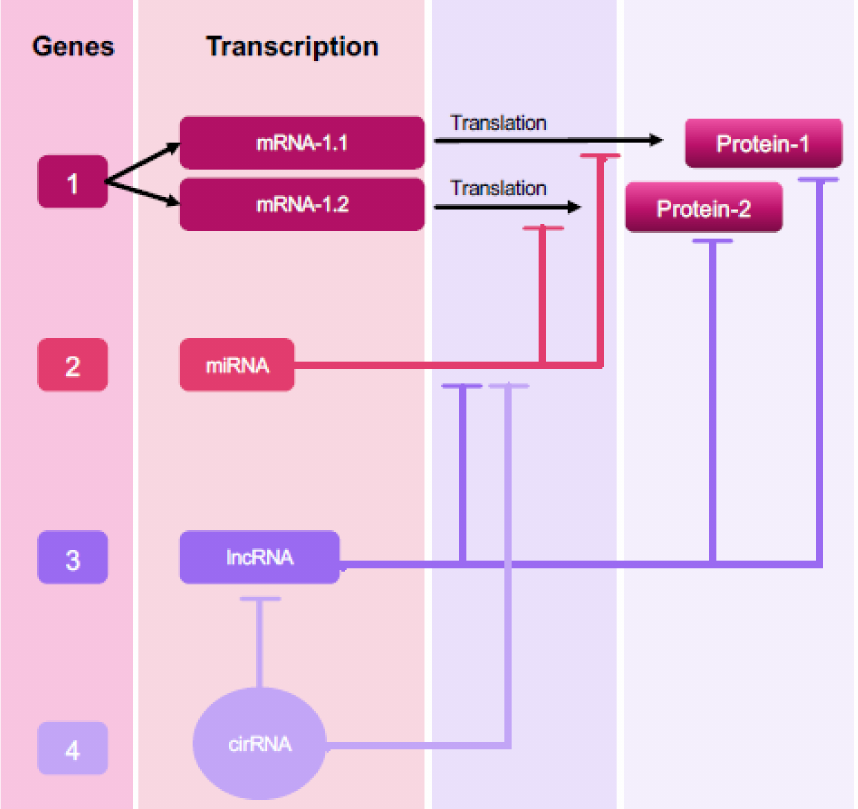
Figure 1. Schematic illustration of the complexity of ncRNA gene networks. In this example, only two splice variants of Gene 1 are translated into proteins. These protein products can be regulated by ncRNAs encoded by Genes 2, 3, and 4, which interact with Gene 1 at the RNA/protein level. Gene 2 encodes miRNAs interacting with mRNAs (mRNA 1.1 and mRNA 1.2). Gene 3 encodes for lncRNAs interacting with the protein products of Gene 1 and acts as a miRNA sponge. Gene 4 encodes for circRNAs serving as a sponge or as a decoy for any RNA-binding event that indirectly regulates Gene 1 products, such as lncRNA or miRNA